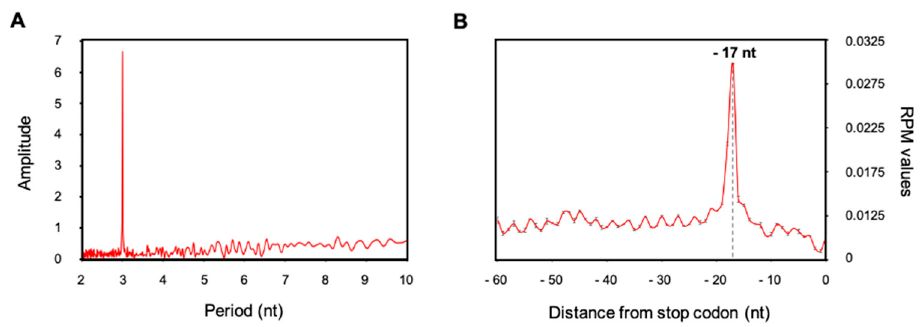
Figure 4 . Read-outs of 5 ′ P degradome library quality. Metagene analysis displaying periodicity between 5 ′ reads extremity ( A ) and 5 ′ P reads accumulation around stop codon ( B ). N = 2, mean ± sd.